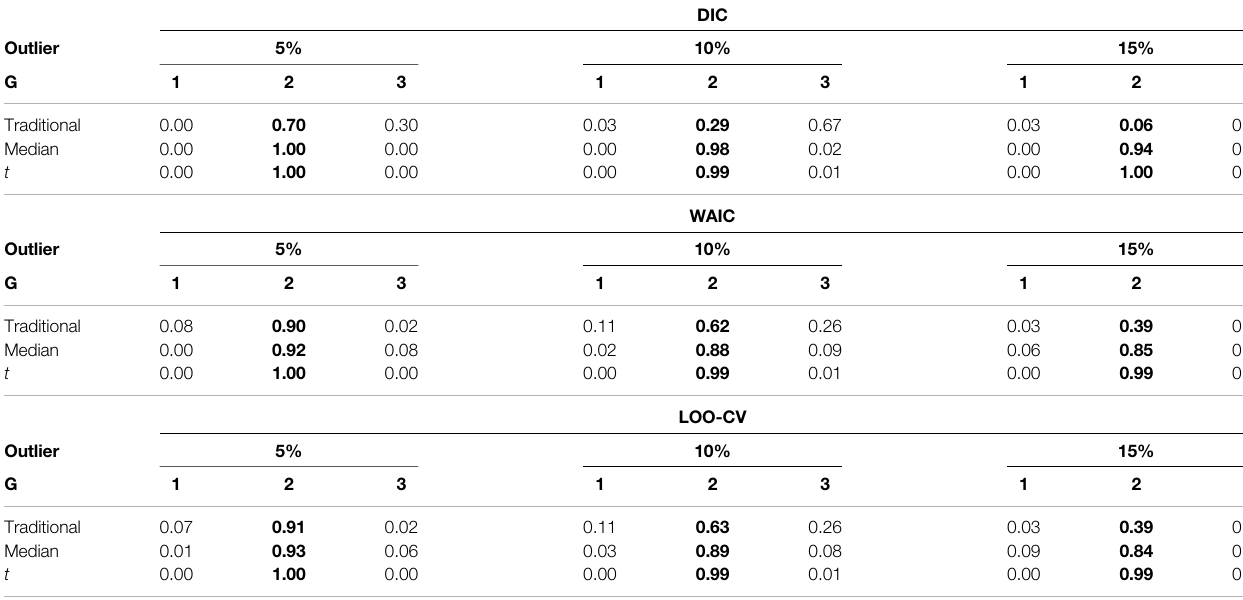
TABLE 5 | Proportion for selecting 1-class, 2-class, and 3-class models using DIC, WAIC, and LOO-CV when N (cid:1) 500.